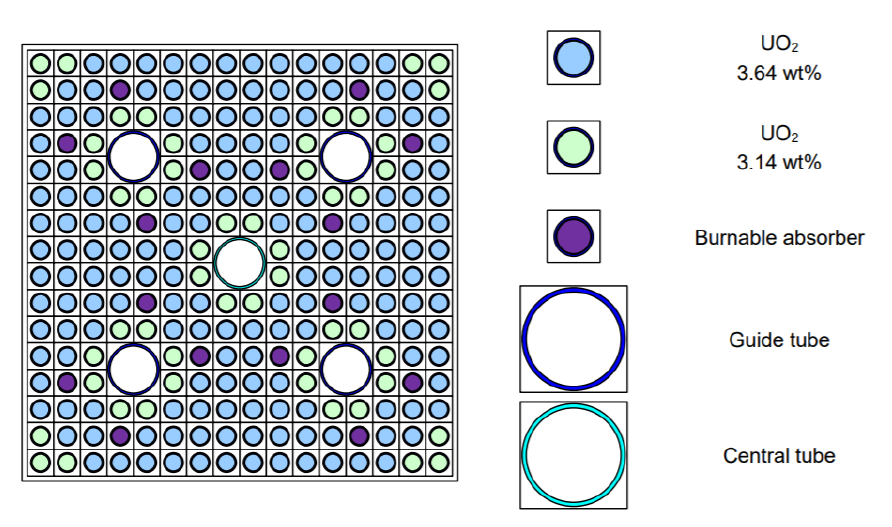
Figure 3. Radial Layout of C2 Fuel Assembly [6].